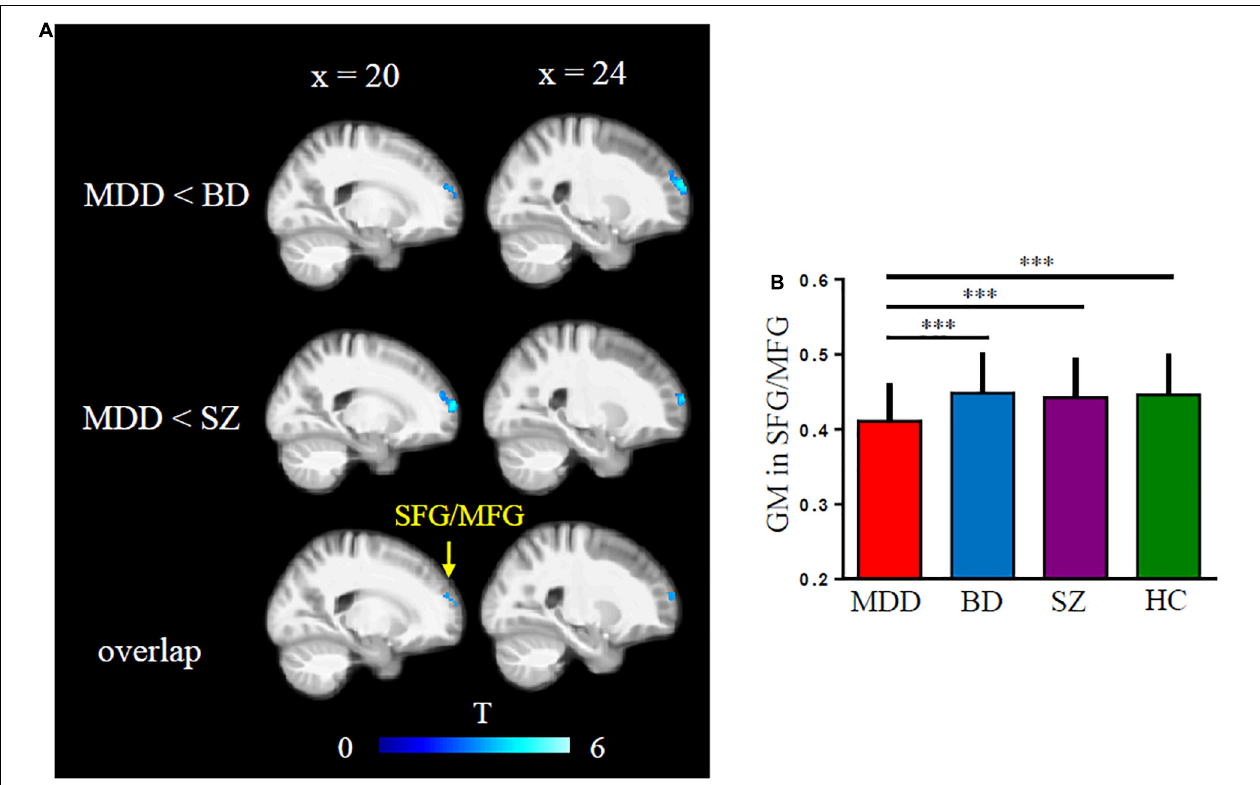
FIGURE 2 | Major depressive disorder (MDD) showed reduced gray matter (GM) volumes in superior and middle frontal gyri (SFG/MFG) compared with bipolar disorder (BD) and schizophrenia (SZ) patients (A,B)